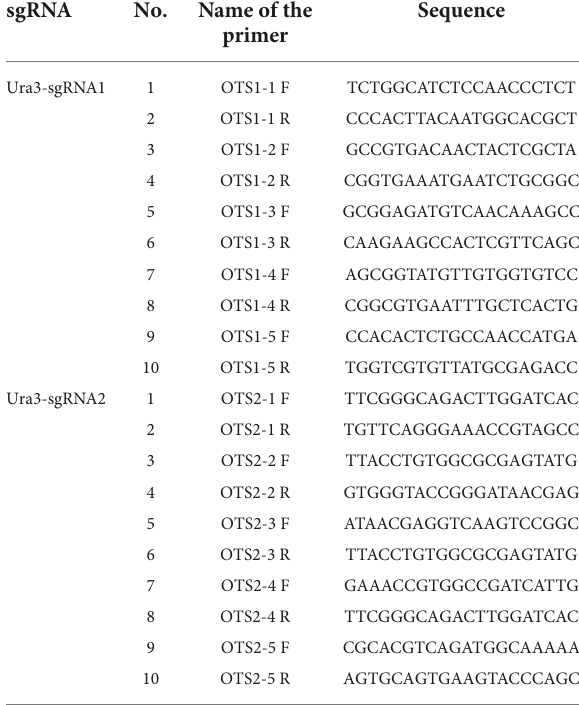
TABLE 2 The primers for the detection of potential off-target site by PCR